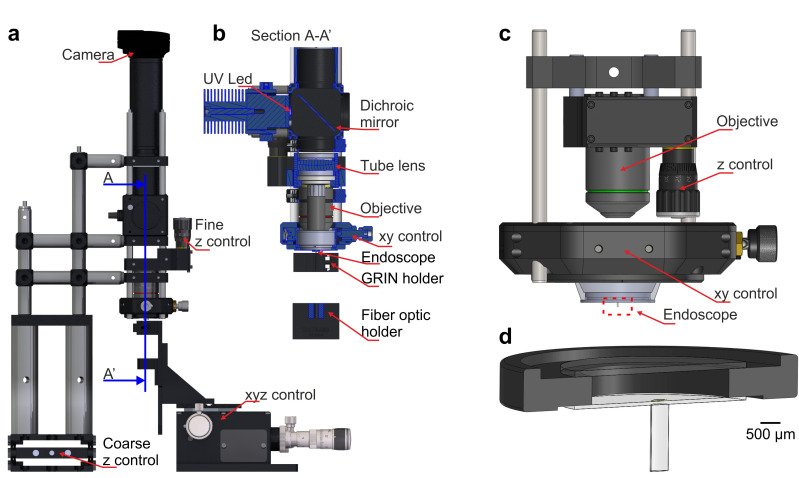
Set-ups for the assembly and characterization of eFOV-microendoscopes.(a) Optomechanical stage used for microendoscope assembly. Red arrows indicate key components. The blue line indicates the plane used for the cross-section view shown at an expanded scale in b. (b) Section (A–A’) of the set-up shown in a. (c) Schematic of the optomechanical assembly used for microendoscopic imaging. (d) The eFOV-microendoscope assembly for implantation highlighted with the red dotted line in (c) is shown at an expanded scale.